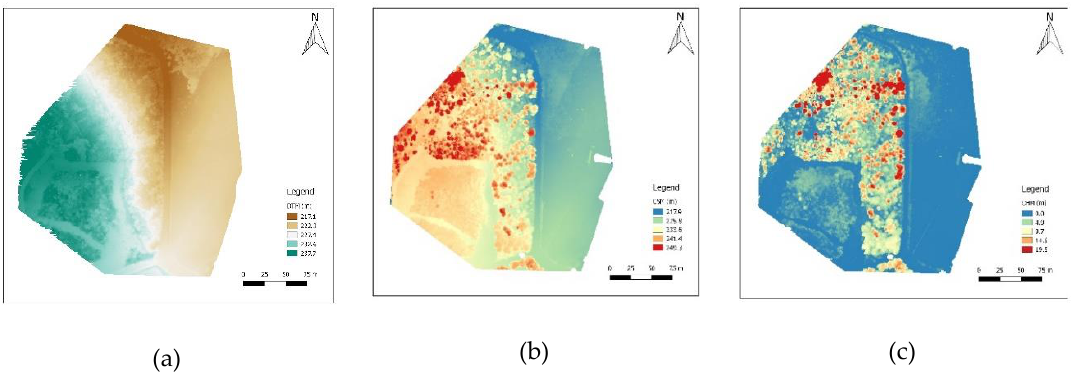
Figure 6. Different models generated for Dataset 2: ( a ) Digital Terrain Model (DTM); ( b ) Canopy Surface Model (CSM); and ( c ) Canopy Height Model (CHM). Heights are expressed in meters.